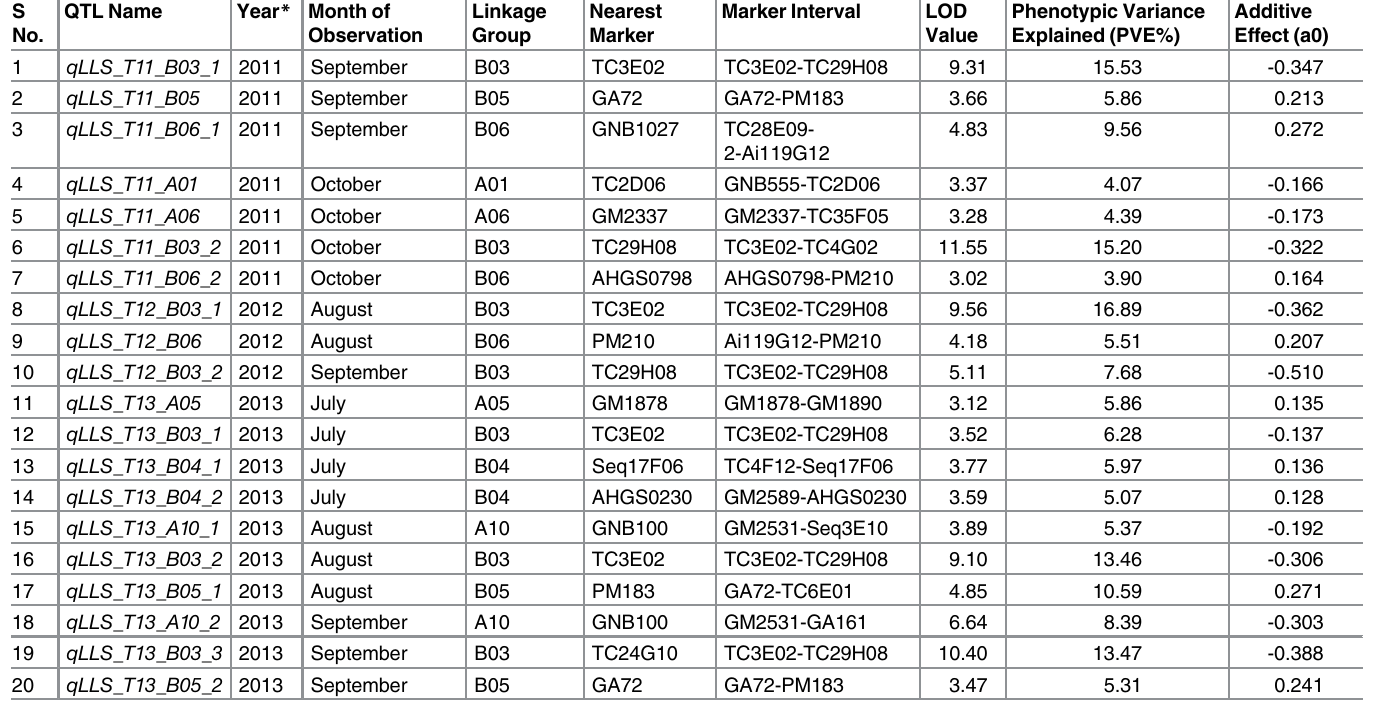
Table 6. QTLs identified for late leaf spot (LLS) resistance in